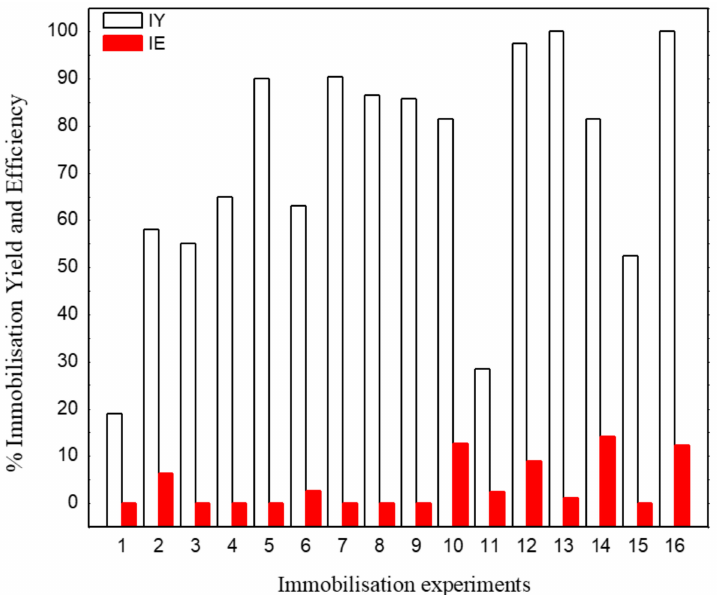
Figure 5. Immobilization yield (IY) and immobilization e ffi ciency (IE): pH 4.0 (odd-number experiments), pH 8.0 (even-number experiments), and temperature 25 ◦ C (experiments 1 until 8) and 60 ◦ C (experiments 9 until